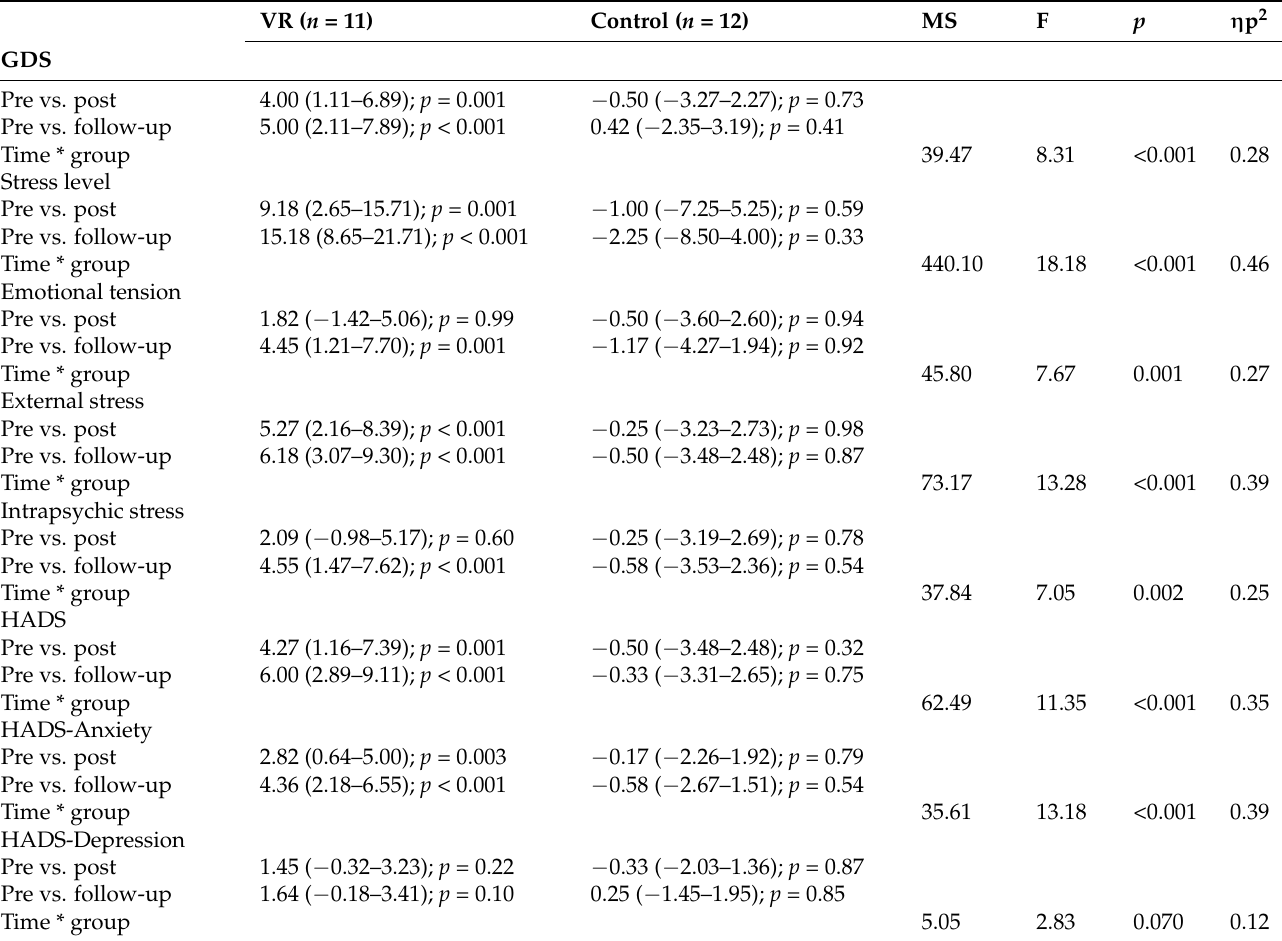
Table 3. VR therapy effects, mean differences (95%